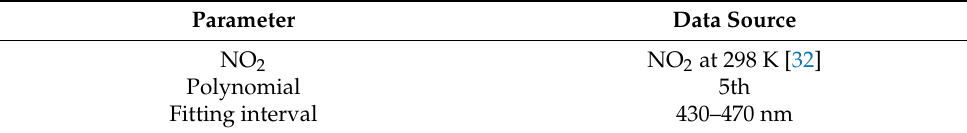
Table 2. NO 2 DOAS fit settings.